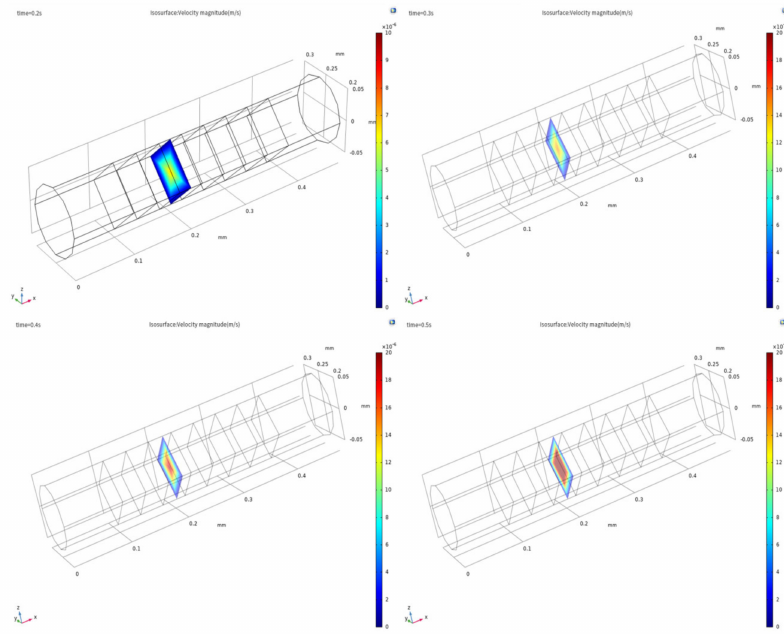
Figure 6. Axial velocity field distribution of the yz plane in the sensing element under sinusoidal excitation signal in the quarter cycle.